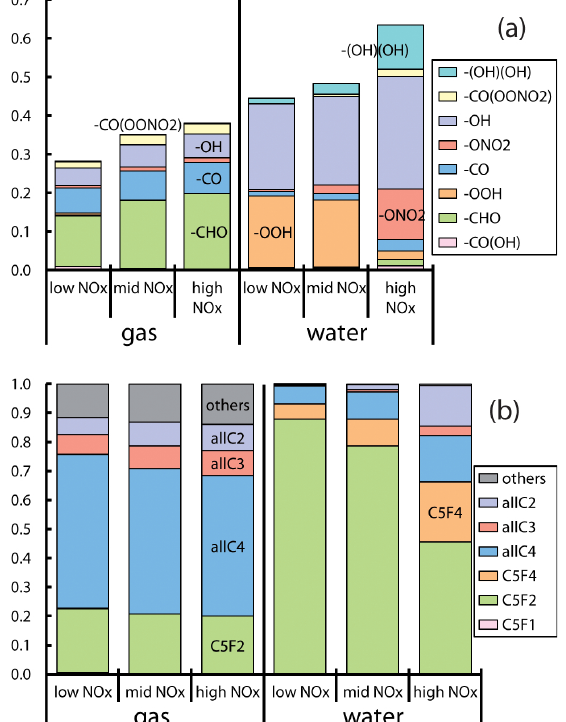
Fig. 3. At N τ = 2, simulated distribution in gaseous and aqueous phase of organic moieties ratio ( R OF / C , panel a ) and functional- ization (panel b ) for a cloud water content during the oxidation of isoprene. C m F n category merges species with m carbon atoms bear- ing n functional groups. The precursor and C 1 species are lumped in the others category.